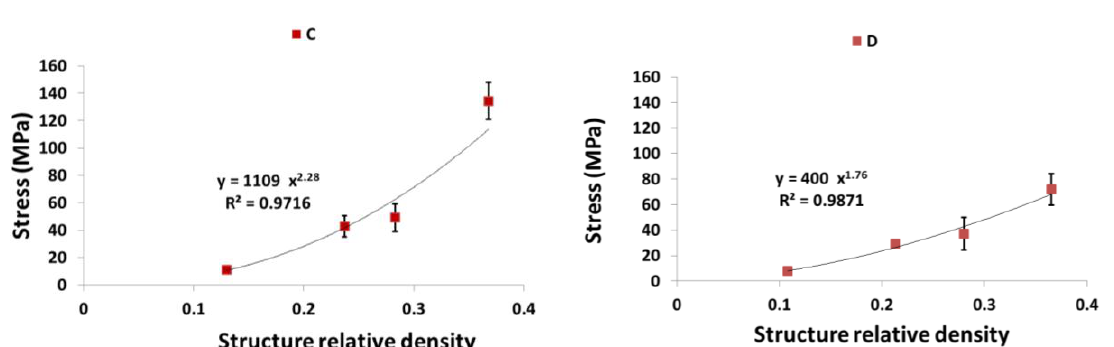
Figure 10. Summary of the first maximum stress results for porous structures based on different types of unit cell configurations (cubic (C); diamond (D); truncated cube (TC); truncated cuboctahedron (TCO); rhombic dodecahedron (RD); rhombicuboctahedron (RCO)) and different structure relative densities (see Table